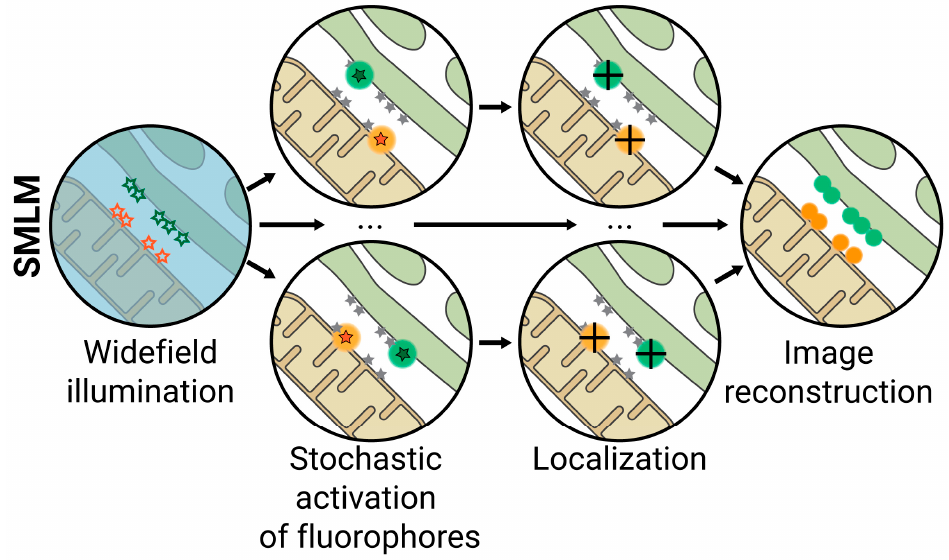
Figure 6. Single Molecule Localization Microscopy (SMLM). Fluorescent dyes that stochastically cycle between the on and off states are used, so in each frame, only a subset of fluorophores is excited and will emit fluorescence, avoiding overlapping excitation signals. For each frame, the center-of-mass of the PSF of each fluorophore is calculated to determine its localization (black cross) and reconstruct a super-resolved image. Lateral resolution ≈ 20 nm; axial resolution ≈ 50 nm.